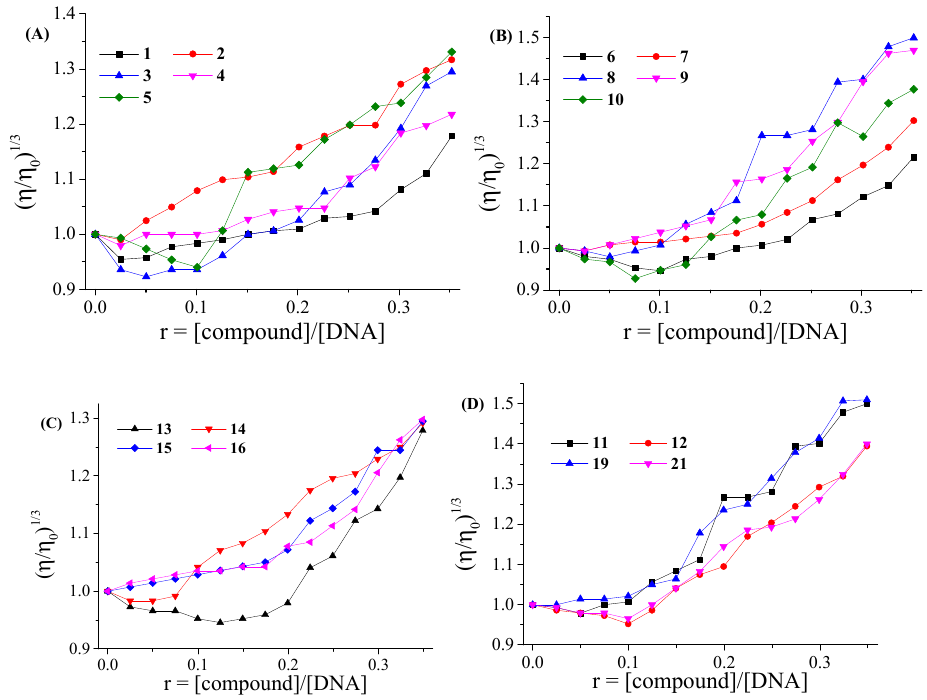
Figure 8. Relative viscosity ( η / η o ) 1/3 of CT DNA (0.1 mM) in buffer solution (150 mM NaCl and 15 mM trisodium citrate at pH 7.0) in the presence of compounds ( A ) 1 – 5 , ( B ) 6 – 10 , ( C ) 13 – 16 and ( D ) 11 , 12 , 19 and 21 at increasing amounts ( r = [compound]/[DNA]).